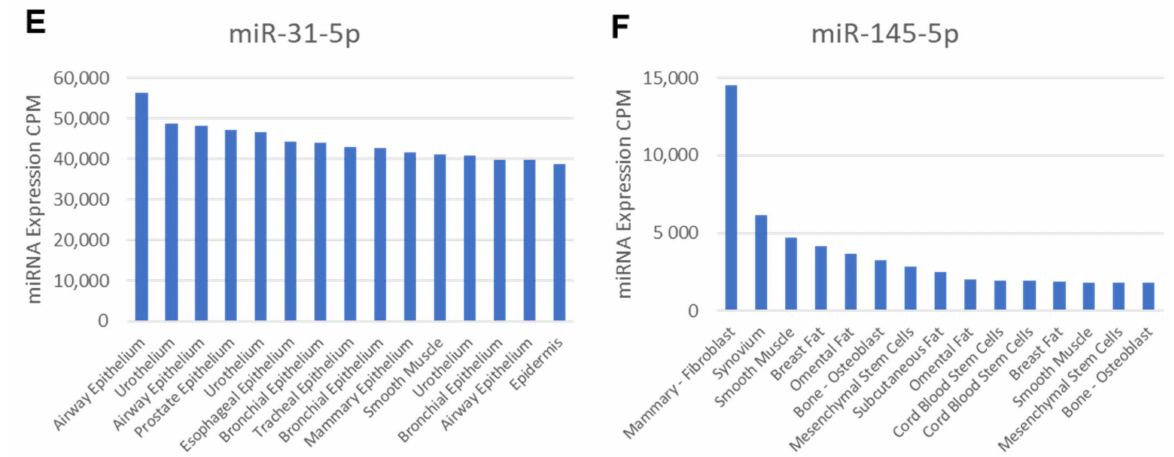
Figure 6. Tissue/cell-type specificity based on the FANTOM5 atlas browser of miRNAs rescued by treatment. Using the FANTOM5 browser, the expression profiles of dysregulated circulating miRNAs in ZDF rats rescued by insulin ( A – E ) or anti-Scl ( F ) across the top 15 tissues were obtained (no data were available for miR-802-5p). Y-axis indicates the level of expression in CPM of the miRNA for each analyzed cell/tissue sample; x-axis shows the position of each cell/tissue sample where the miRNA was detected, and the full name of which (given by FANTOM5) was